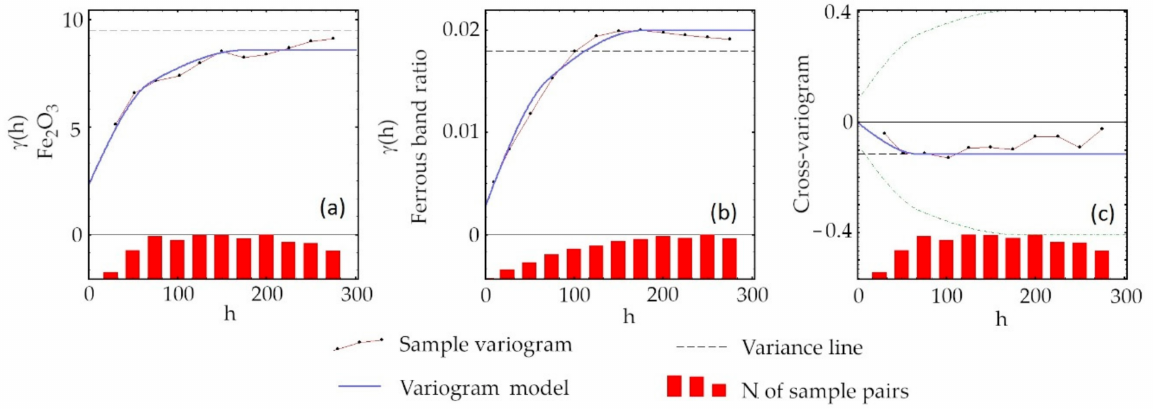
Figure 7. Sample variograms and variogram models for iron concentration obtained by samples Fe 2 O 3 (%) ( a ), ferrous iron oxides band ratio ( b ) and cross-variogram ( c ). h(m) is the distance and γ (h) is the sample